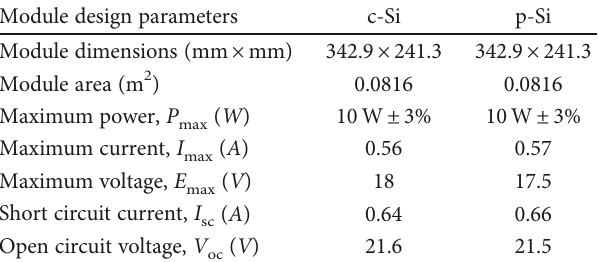
Table 1: Module speci fi cations.